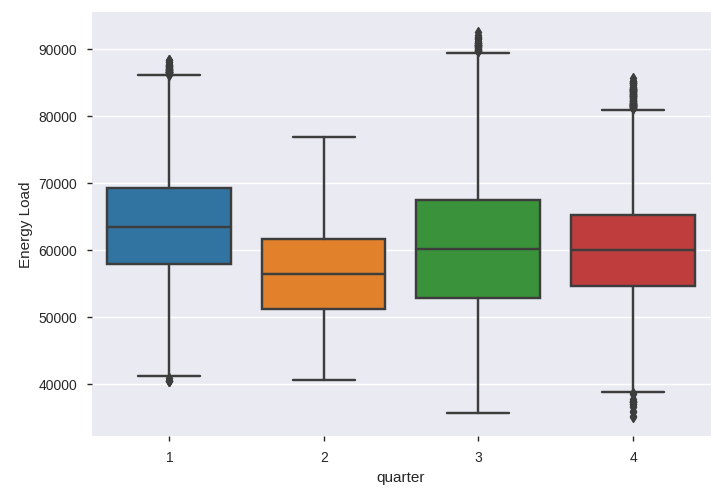
Figure 10. Seasonality analysis: Distribution over quaters.